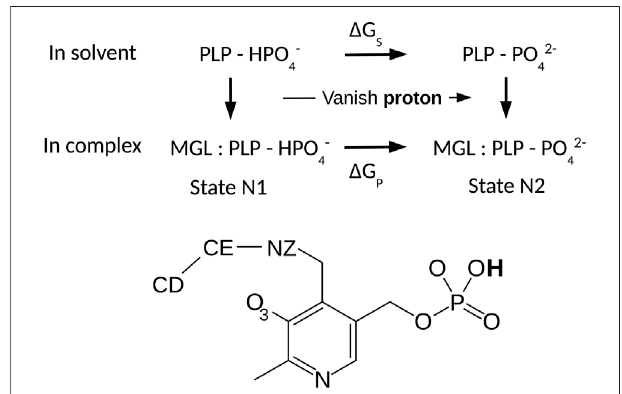
FIGURE 2 | Thermodynamic cycle for phosphate deprotonation. The horizontal legs correspond to deprotonation and have free energies Δ G S and Δ G P . Vertical legs correspond to PLP:MGL binding. PLP is shown